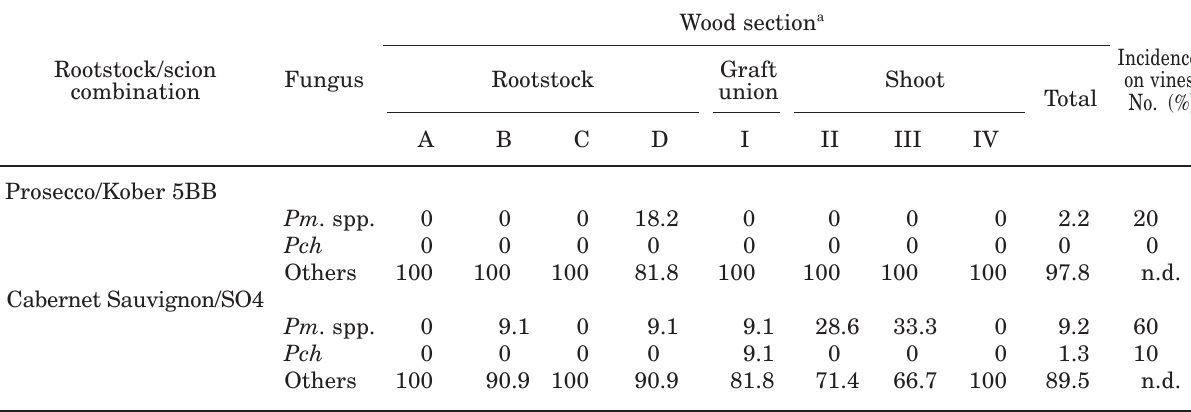
Table 3. Percentage of esca-associated ( Phaeoacremonium spp. , Pm. spp.; Phaeomoniella chlamydospora, Pch) and other fungi isolated from wood segments of 1-year-old vines of two rootstock and scion combinations, uprooted in 2001, and mean incidence of colonized vines. Wood section a Incidence Rootstock/scion Graft Fungus Rootstock Shoot on vines combination union